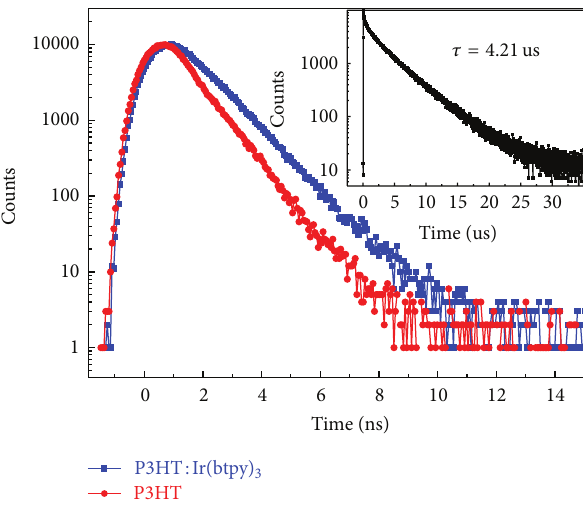
Figure 5: Time-resolved transient PL spectra of P3HT and P3HT:Ir(btpy) 3 films by monitoring 650nm under the excitation of 460 nm light. The inset image is the time-resolved transient PL spectra of Ir(btpy) 3 film by monitoring 650 nm.